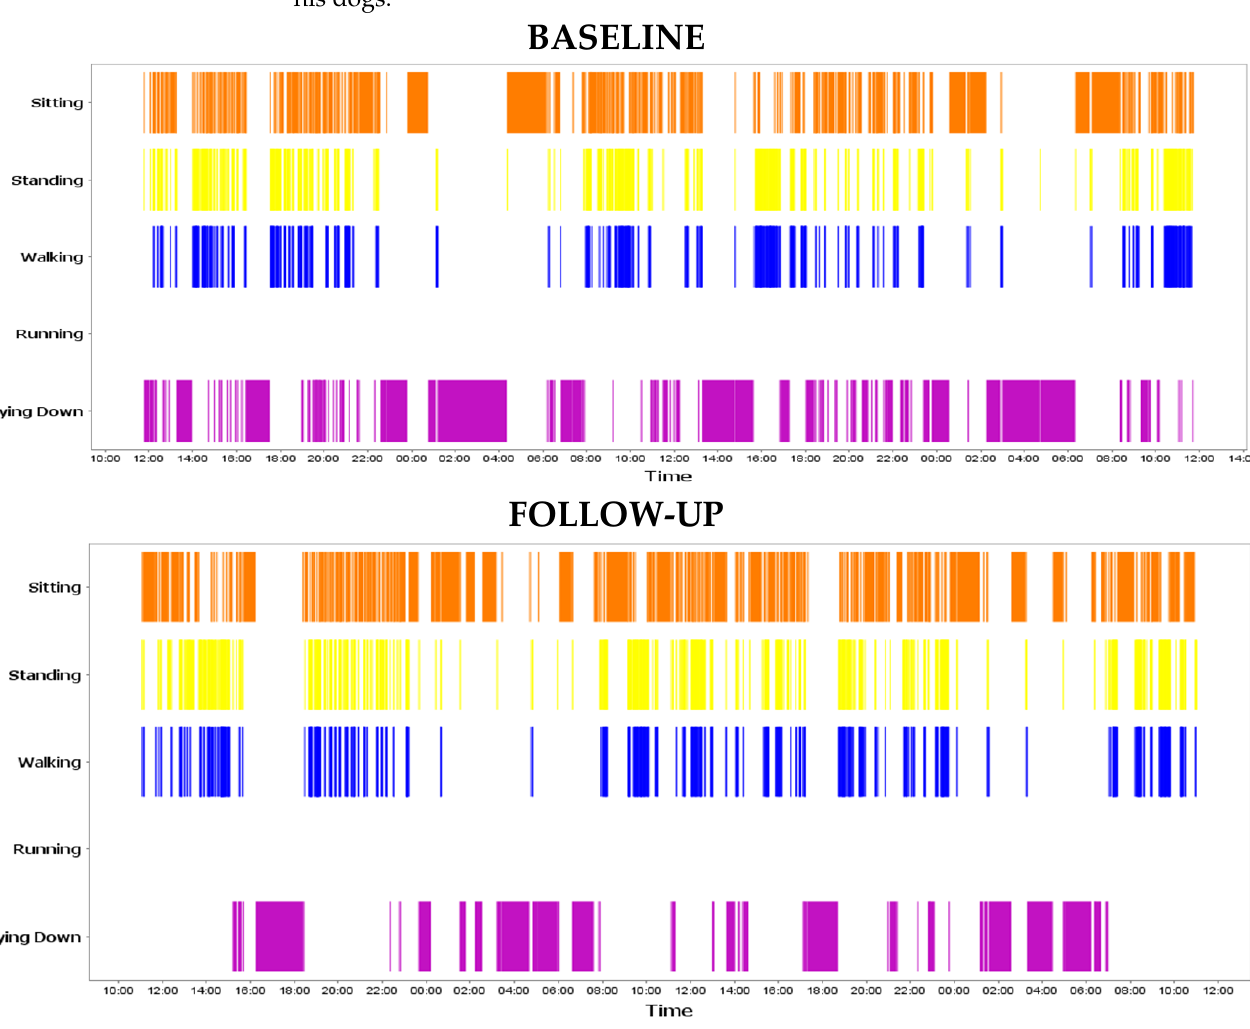
Figure 4. Change in activity timelines from baseline to follow-up. Table 3. Case Descriptions: All measures are reported for a period of 24 h. Change is the difference between measurement at baseline and follow-up.